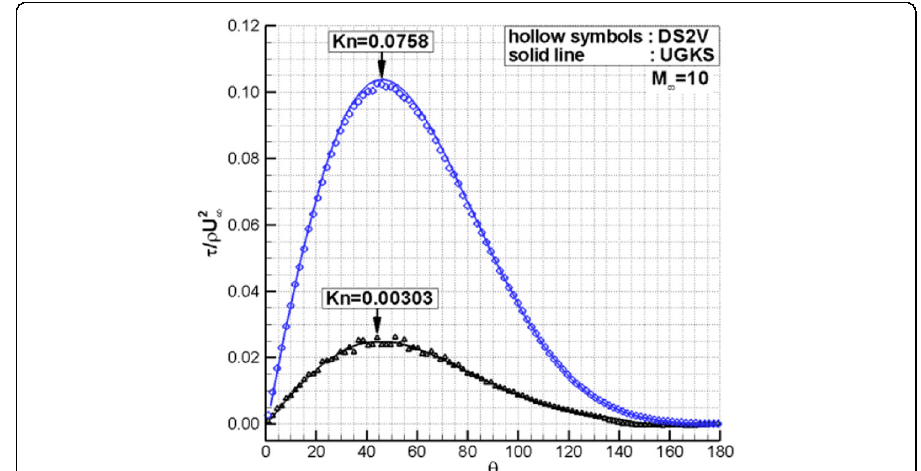
Fig. 19 Shear stress distributions on the cylinder surface at M = 10